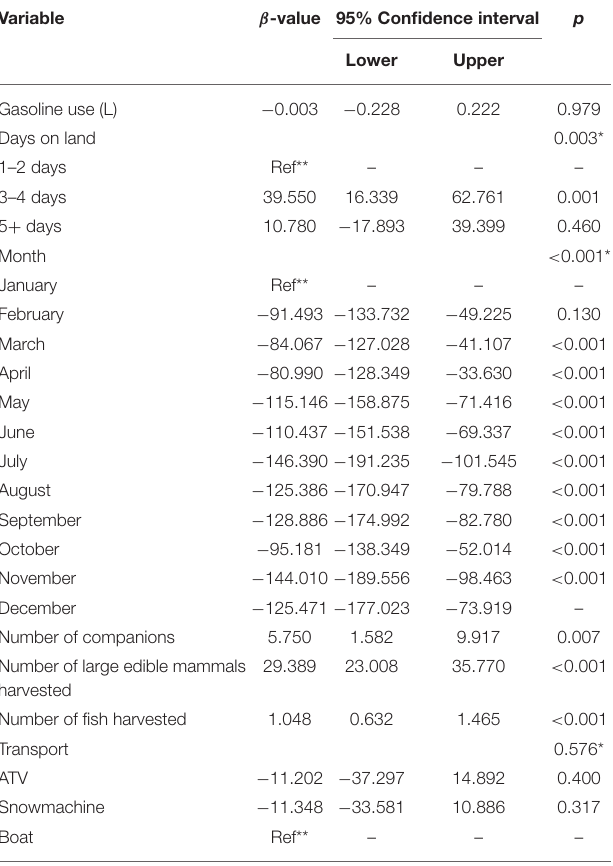
TABLE 3 | Results of the multivariable linear regression investigating association between socio-economic and biophysical variables and hunting productivity in Ulukhaktok, Jan–Dec 2019; Final MvLRM BIC = 958.679 †